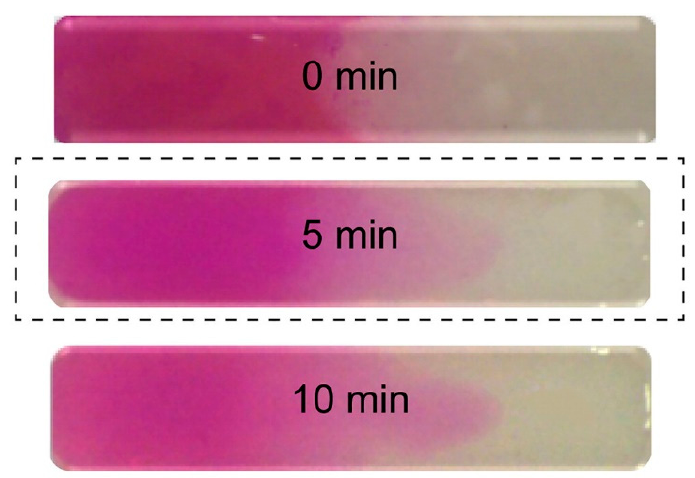
Figure 1. Formed uniform gradient (the optimal time for the uniform mixing of solutions was observed to be 5 min) [12].